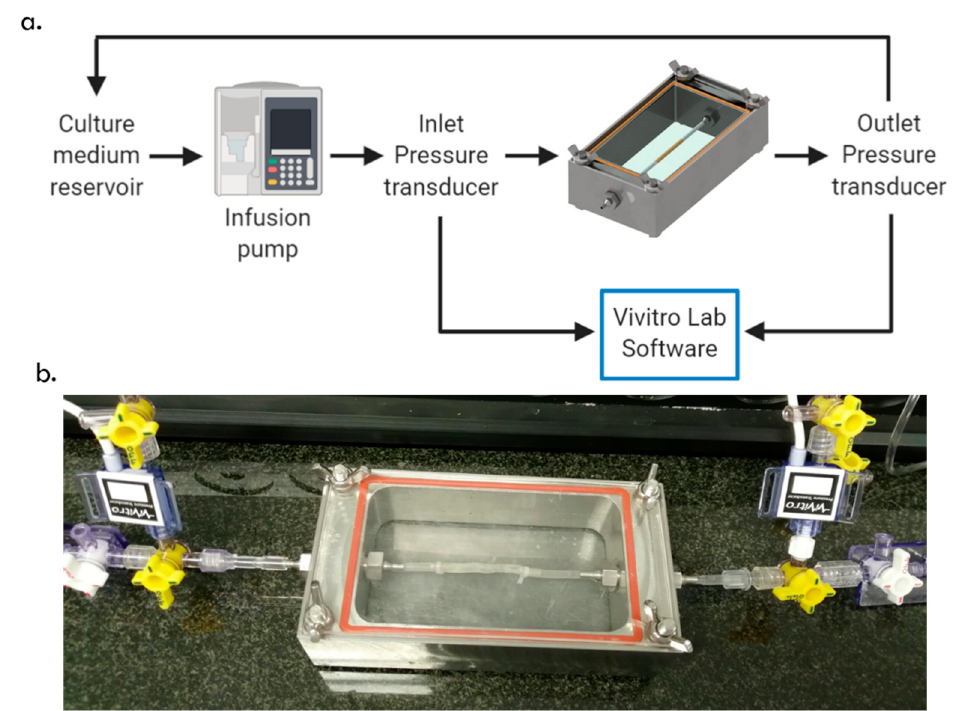
Figure 4. Experimental setup. ( a ) Schematic of the fluidic device and the required accessories for pressure measurement. ( b ) Picture of the actual implementation.